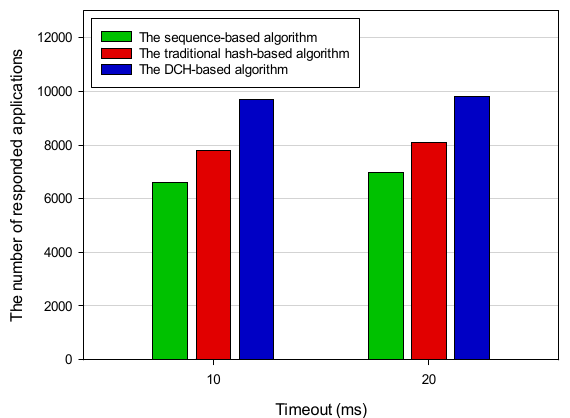
Figure 15. The throughput based on different deploying algorithms.